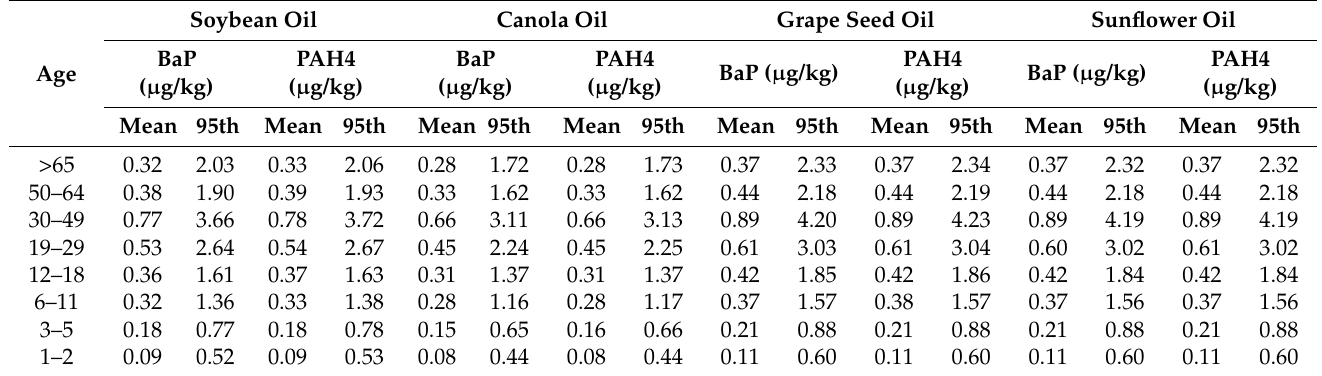
Table 4. Comparison of CDI of fried pork by oil type for each